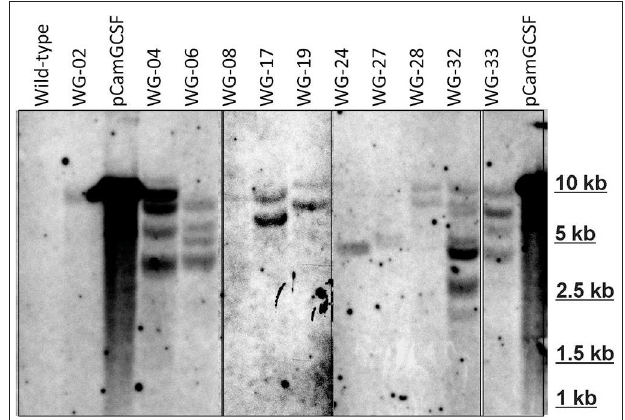
FIGURE 4 | Southern hybridization analysis of some EHA105/ pCamGCSF-transformed Wolffia plants. DNA (10 µ g) digested with HindIII and hybridized with a 600-bp hG-CSF probe. pCamGCSF, pDNA (pCamGCSF/ HindIII ) ; WG, DNA of transgenic Wolffia lines digested with HindIII; Wild-type, genomic DNA of wild-type Wolffia plants digested with